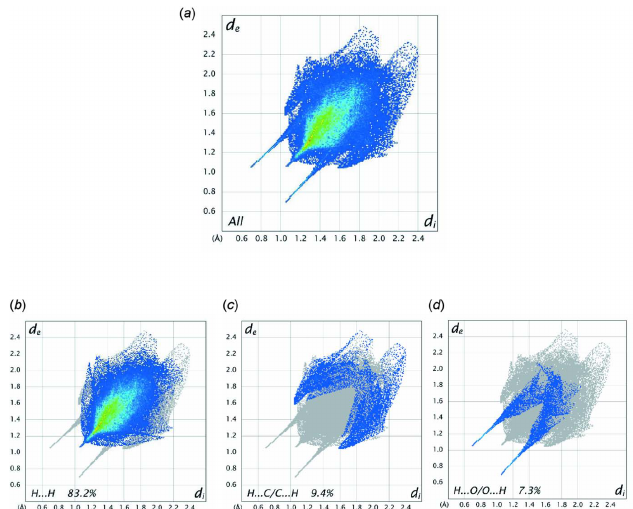
Figure 7 A full two-dimensional fingerprint plot for 1 , ( a ), together with ( b )–( d